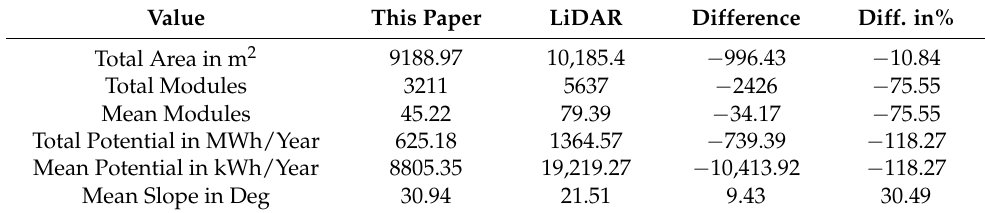
Table 1. Comparison of presented methodology and LiDAR approach.